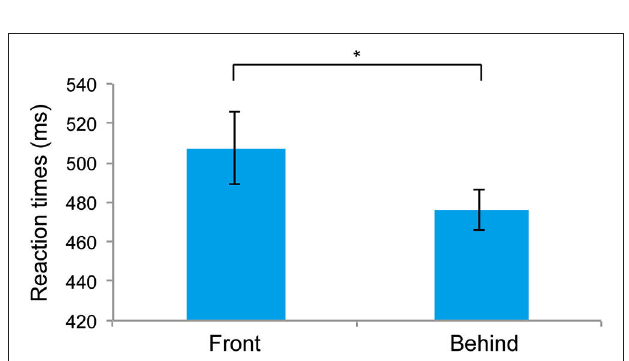
FIGURE 2 | Mean reaction times (RTs) recorded in Experiment 1 . The error bars represent the standard error of the mean. * P < 0.05.